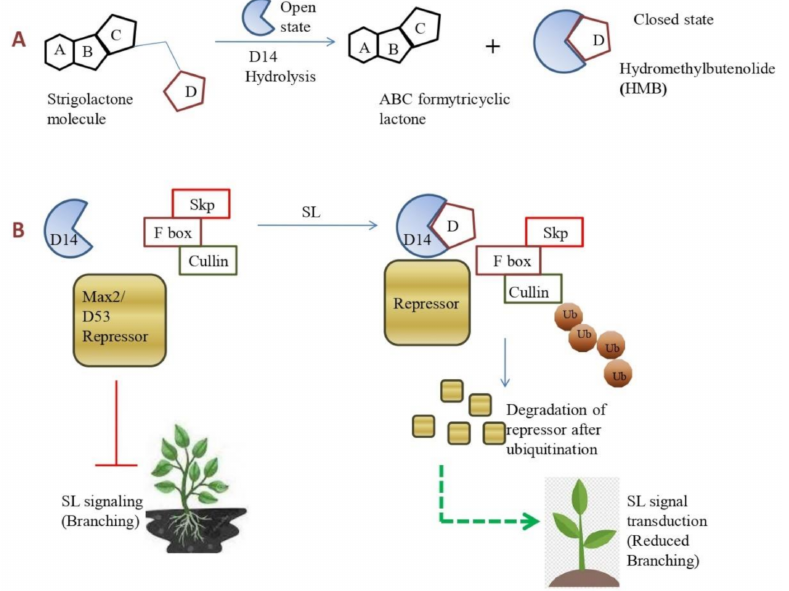
Figure 3. Signal transduction pathway of SLs and protein interaction. ( A ) Degradation of D14 into ABC-FTL and HMB. The figure also shows the open (inactive) and closed (active) conformation of D14 with the “D” ring. ( B ) Interaction of D14 (DWARF 14) with F-box protein D3 and a repressor D53 mediating the signaling pathway. In the absence of SLs, D53 arrests SLs transduction, however, SLs repressor is degraded through controlled ubiquitination followed by SLs release and successful transduction. SLs (Strigolactones); D14 (DWARF 14); ABC-FTL (ABC formlytricyclic lactone); HMB (Hydroxymethylbutenolide); D3 (DWARF 3); D53 (DWARF